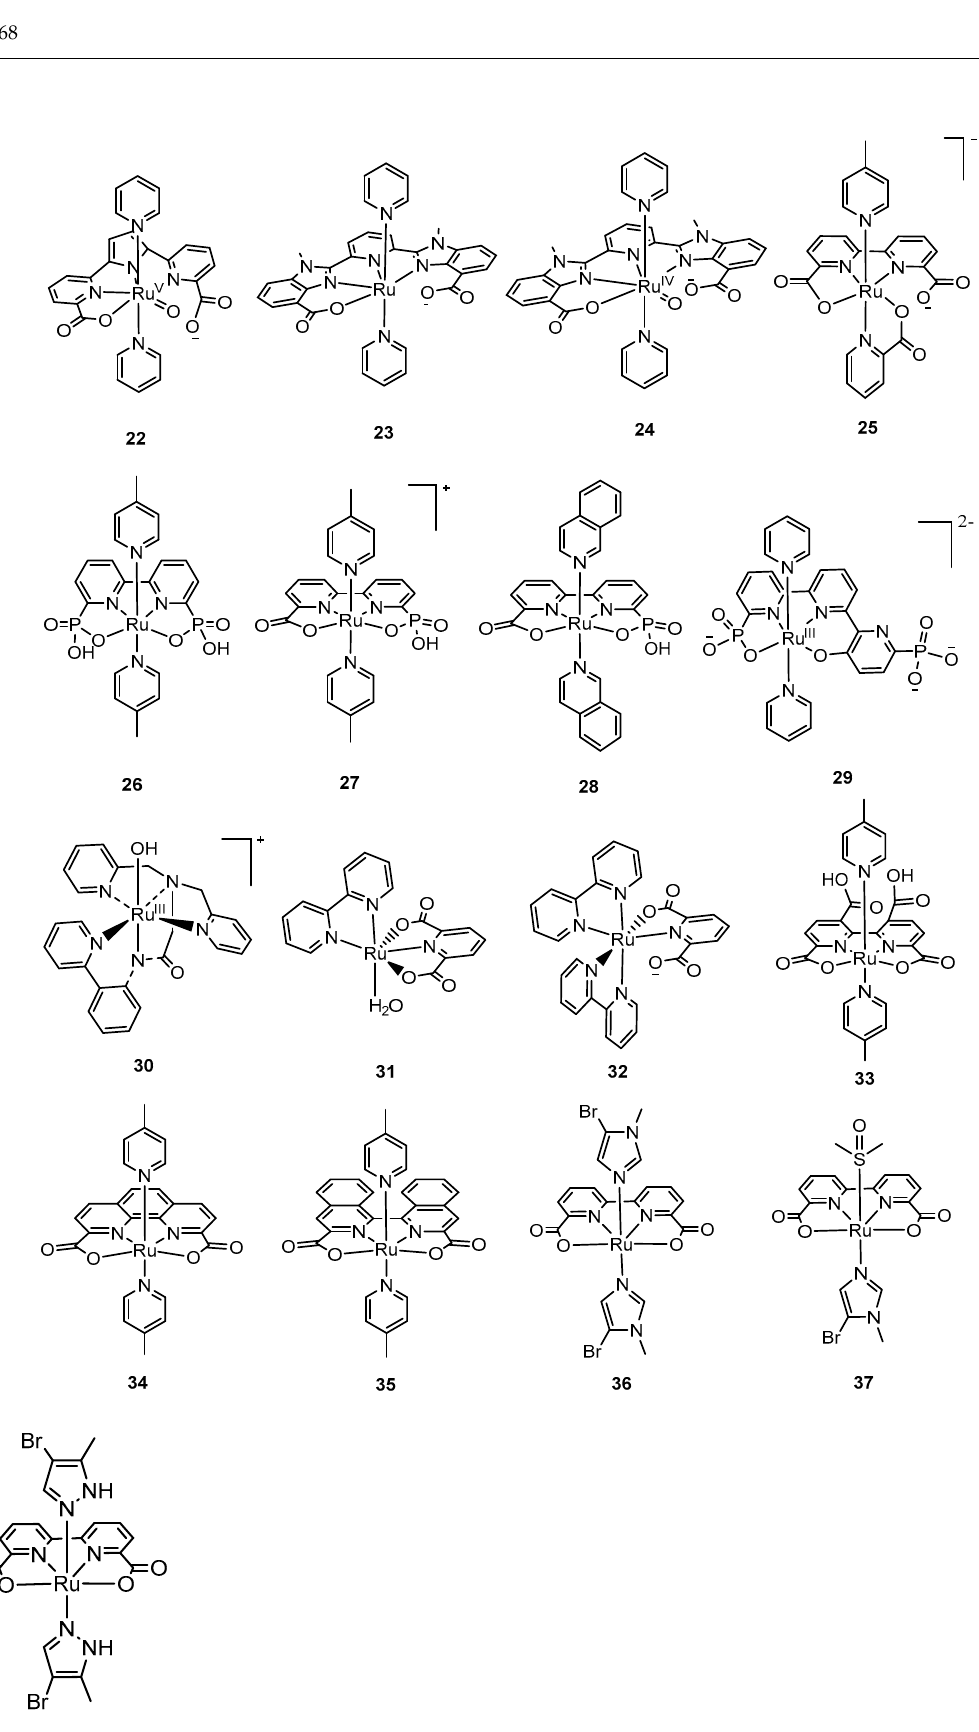
Figure 4. Selected mononuclear ruthenium complexes 11–38 for water oxidation: [(ntp)(pic) 2 Ru(H 2 O)] 2+ ( 11 , ntp = 2,6-di (1,8-naphthyridin-2-yl)-4-tert-butylpyridine, pic = 4-picoline) [71,86]; Ru(terpy)(bipy)(OH 2 )] 2+ ( 12a , bipy = 2,2 (cid:48) -bipyridine)